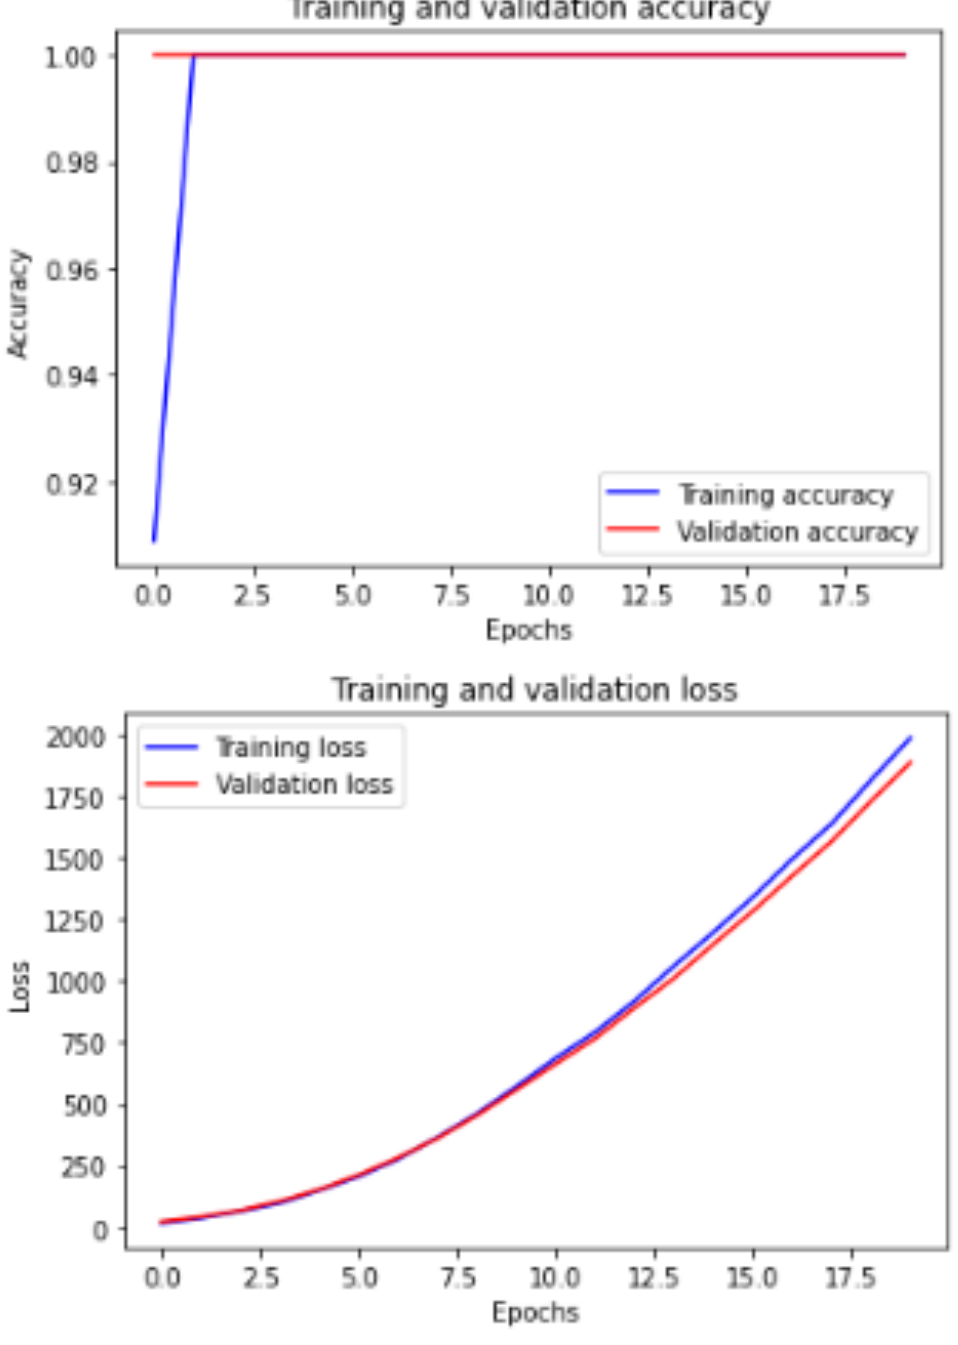
Figure 11. The training and validation ACC and loss through 50 epochs of the InceptionV3